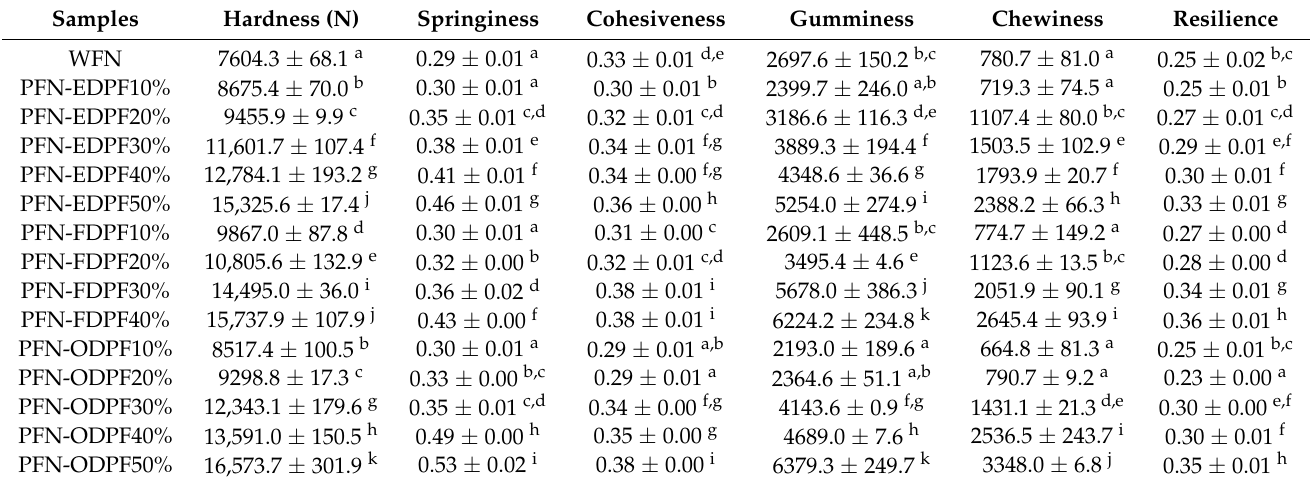
Table 6. Textural characteristics of fresh potato